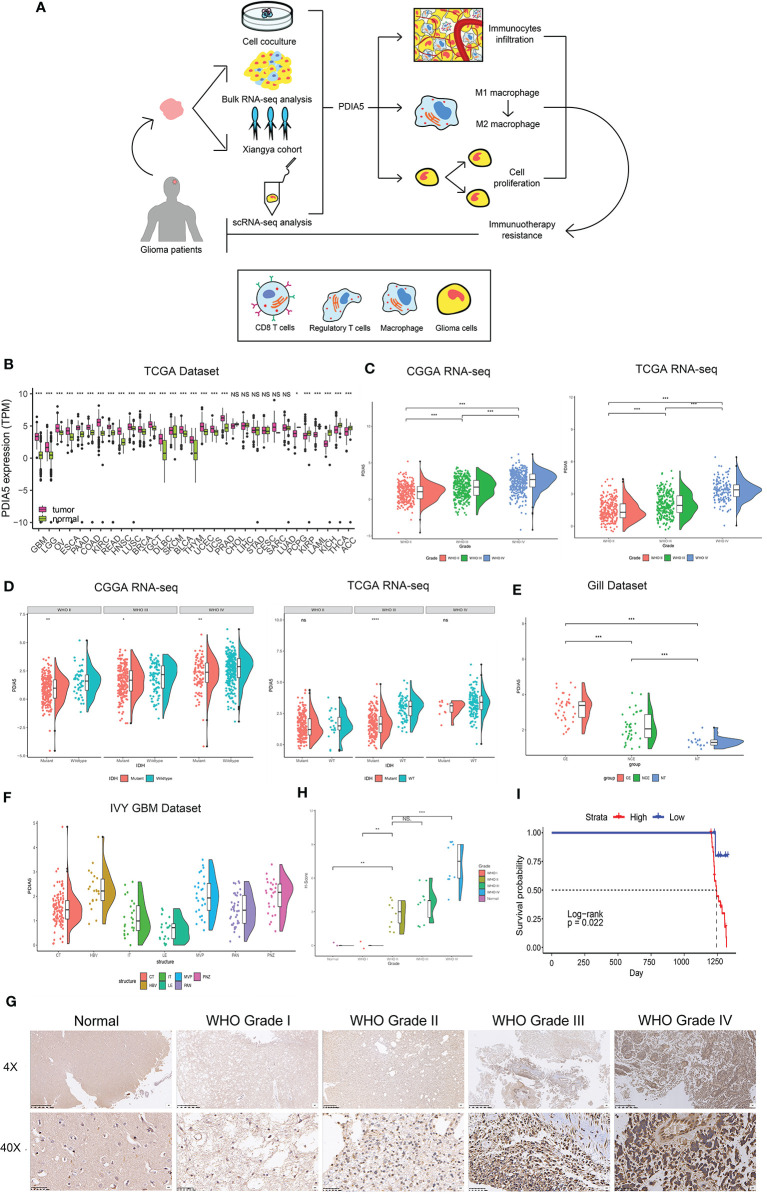
Clinical and molecular characteristics of PDIA5 in gliomas. (A) The flow diagram of this research. (B) Expression of PDIA5 in multiple human cancers from the The Cancer Genome Atlas (TCGA) dataset. GBM, glioblastoma multiforme; LGG, brain lower grade glioma; OV, ovarian serous cystadenocarcinoma; ESCA, esophageal carcinoma; PAAD, pancreatic adenocarcinoma; COAD, colon adenocarcinoma; KIRC, kidney renal clear cell carcinoma; READ, rectum adenocarcinoma; HNSC, head and neck squamous cell carcinoma; LUSC, lung squamous cell carcinoma; BRCA, breast invasive carcinoma; TGCT, testicular germ cell tumors; DLBC, lymphoid neoplasm diffuse large B-cell lymphoma; SKCM, skin cutaneous melanoma; BLCA, bladder urothelial carcinoma; THYM, thymoma; UCEC, uterine corpus endometrial carcinoma; UCS, uterine carcinosarcoma; PRAD, prostate adenocarcinoma; CHOL, cholangiocarcinoma; LIHC, liver hepatocellular carcinoma; STAD, stomach adenocarcinoma; CESC, cervical squamous cell carcinoma and endocervical adenocarcinoma; SARC, sarcoma; LUAD, lung adenocarcinoma; PCPG, pheochromocytoma and paraganglioma; KIRP, kidney renal papillary cell carcinoma; LAML, acute myeloid leukemia; KICH, kidney chromophobe; THCA, thyroid carcinoma; ACC, adrenocortical carcinoma. (C) The expression levels of PDIA5 increased with WHO grade in the Chinese Glioma Genome Atlas (CGGA) and TCGA datasets. (D) PDIA5 expression was upregulated in isocitrate dehydrogenase (IDH) wild-type compared with IDH mutant gliomas in CGGA and TCGA datasets. (E) PDIA5 expression levels in different radiographical regions of glioblastoma multiforme (GBM) and normal brain from the Gill dataset. (F) PDIA5 expression was detected in different locations in the IVY GBM dataset. CT, cellular tumor; HBV, hyperplastic blood vessels; IT, infiltrating tumor; LE, leading edge; MVP, microvascular proliferation; PAN, pseudopalisading cells around necrosis; PNZ, perinecrotic zone. (G) Representative images of IHC staining for PDIA5 in normal brain tissue and different WHO grades of glioma [scale bar=625µm (upper), 50µm (lower)]. (H) Quantification (H-score) of PDIA5 IHC staining in normal brain (n=3) and different pathological grades of gliomas (n=31). (I) Kaplan-Meier survival curves comparing the high and low expression of PDIA5 in glioma patients from Xiangya Hospital. *P <.05, **P <.01, ***P <.001, ns. p>.05.